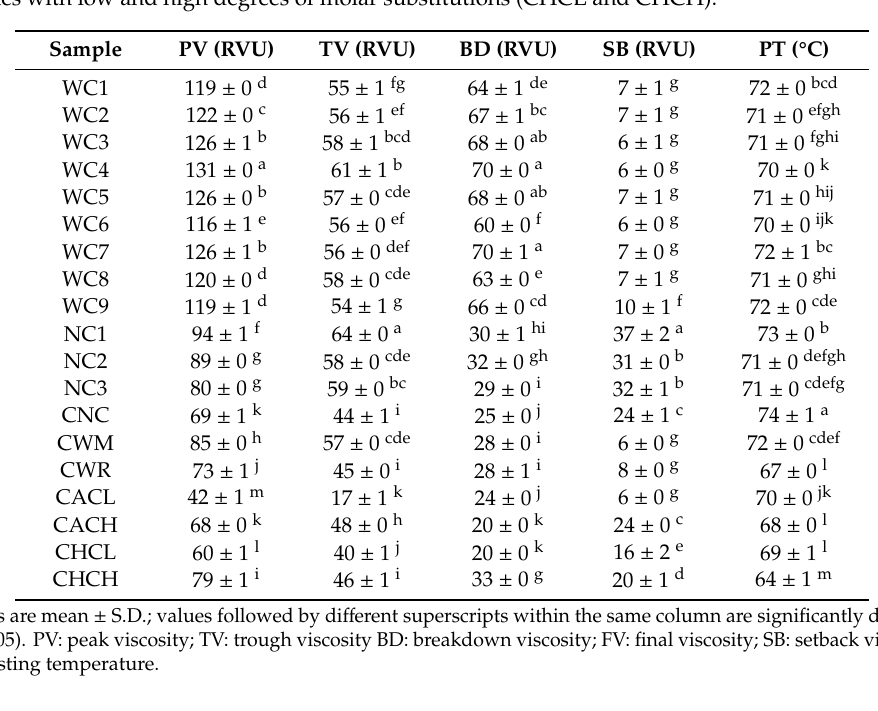
Table2. PastingpropertiesofnineThainon-GMbredwaxycassavastarches(WC1–WC9), threewild-type normal cassava starches (NC1–NC3), commercial normal cassava starch (CNC), commercial waxy maize starch (CWM), commercial waxy rice starch (CWR) and commercial acetylated cassava starches with low and high degrees of substitutions (CACL and CACH) and commercial hydroxypropylated cassava starches with low and high degrees of molar substitutions (CHCL and CHCH).